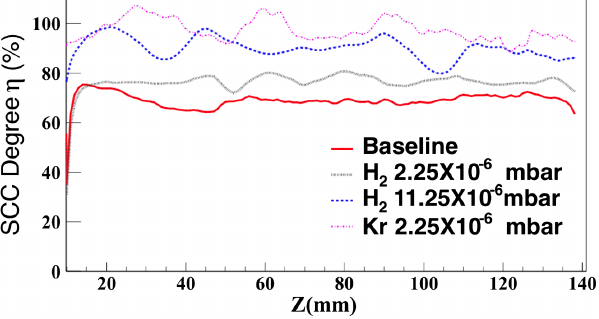
FIG. 18. Simulation results of the space charge compensation degree along the beam center for different injected pressures and gas types.